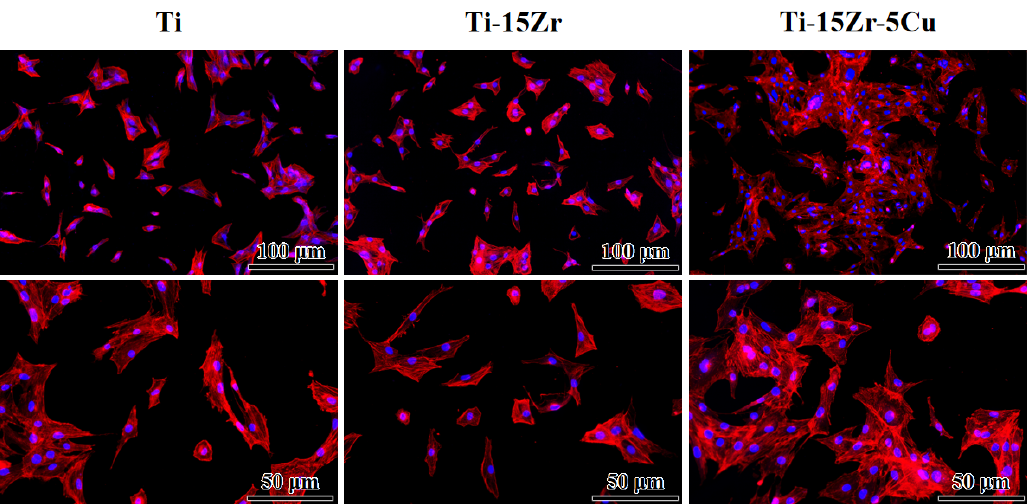
Figure 9. Cytoskeleton staining results of MC3T3-E1 cells co-cultured with the commercial pure Ti, the Ti15Zr alloy and the ultrafine-grained Ti15Zr5Cu alloy.